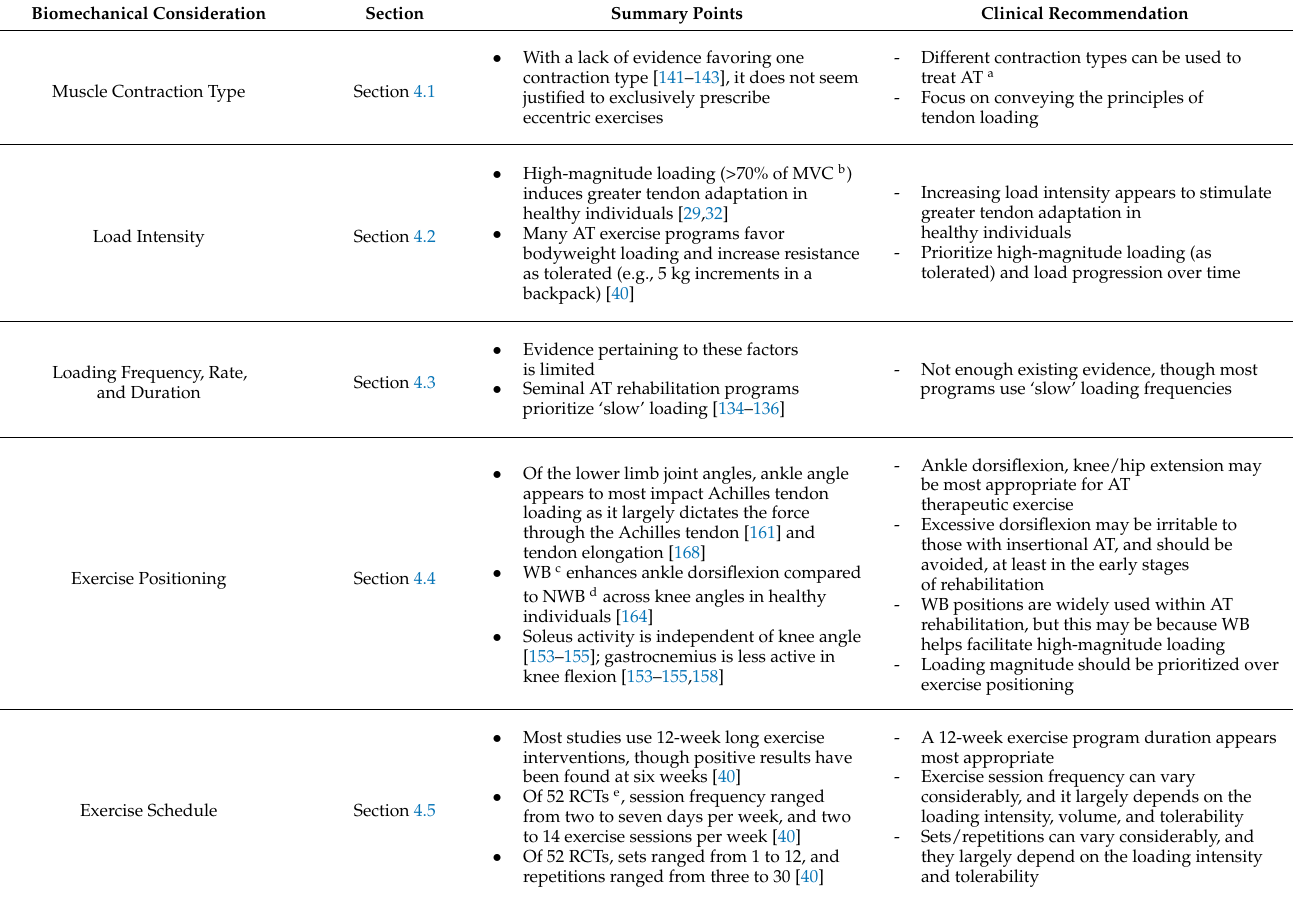
Table 1. Clinical takeaways for resistance-exercise based Achilles tendinopathy